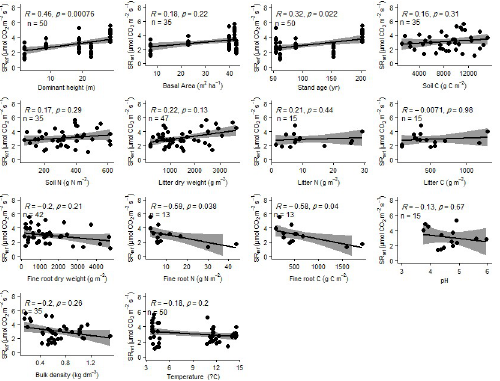
Fig 5. Relationships between reference soil respiration at 10˚C (SR ref ) and different site